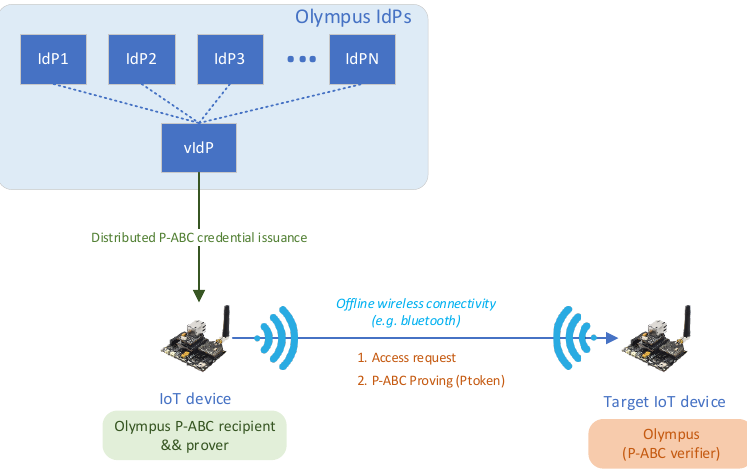
Figure 7. Olympus in the Internet of Things (IoT) setting for privacy-preserving M2M